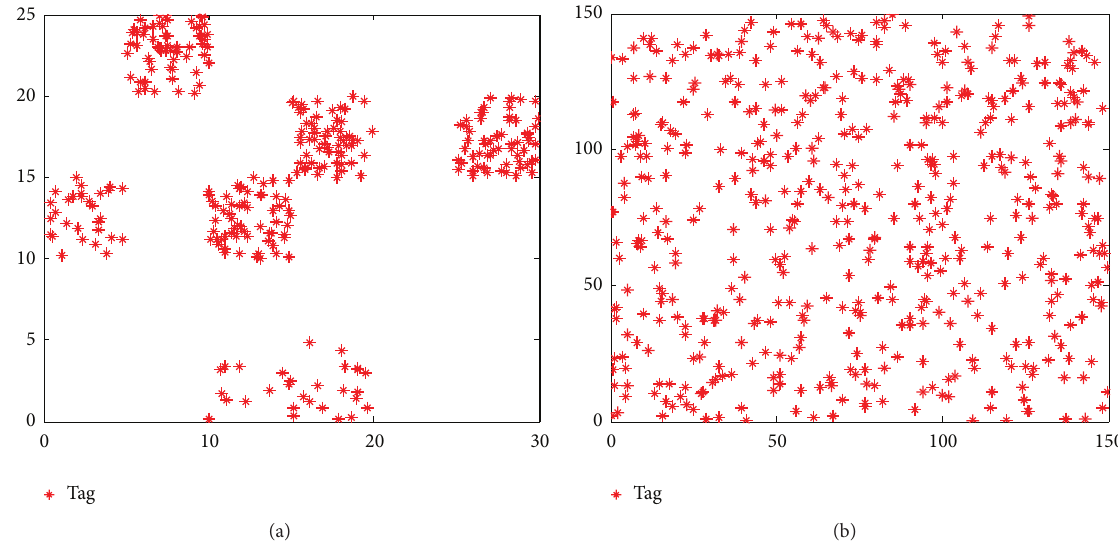
Figure 8: The test working area tags deployment: (a) cluster deploying with 100 tags (Cd100); (c) randomly deploying with 500 tags (Rd500).